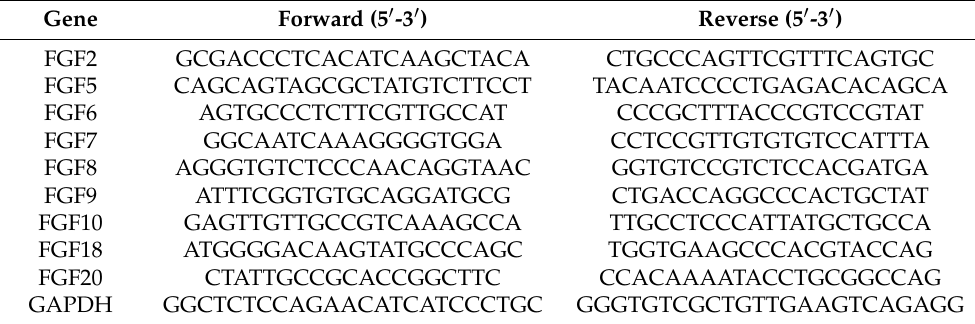
Table 1. Primer sequences for